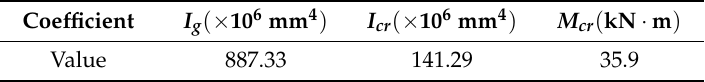
Table 2. Values of effective moments of inertia.